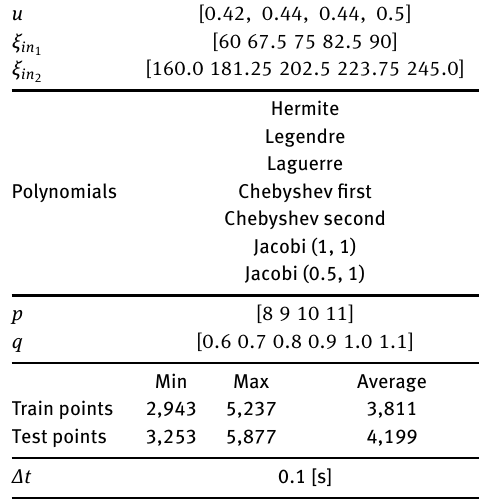
Table 2: Algorithm